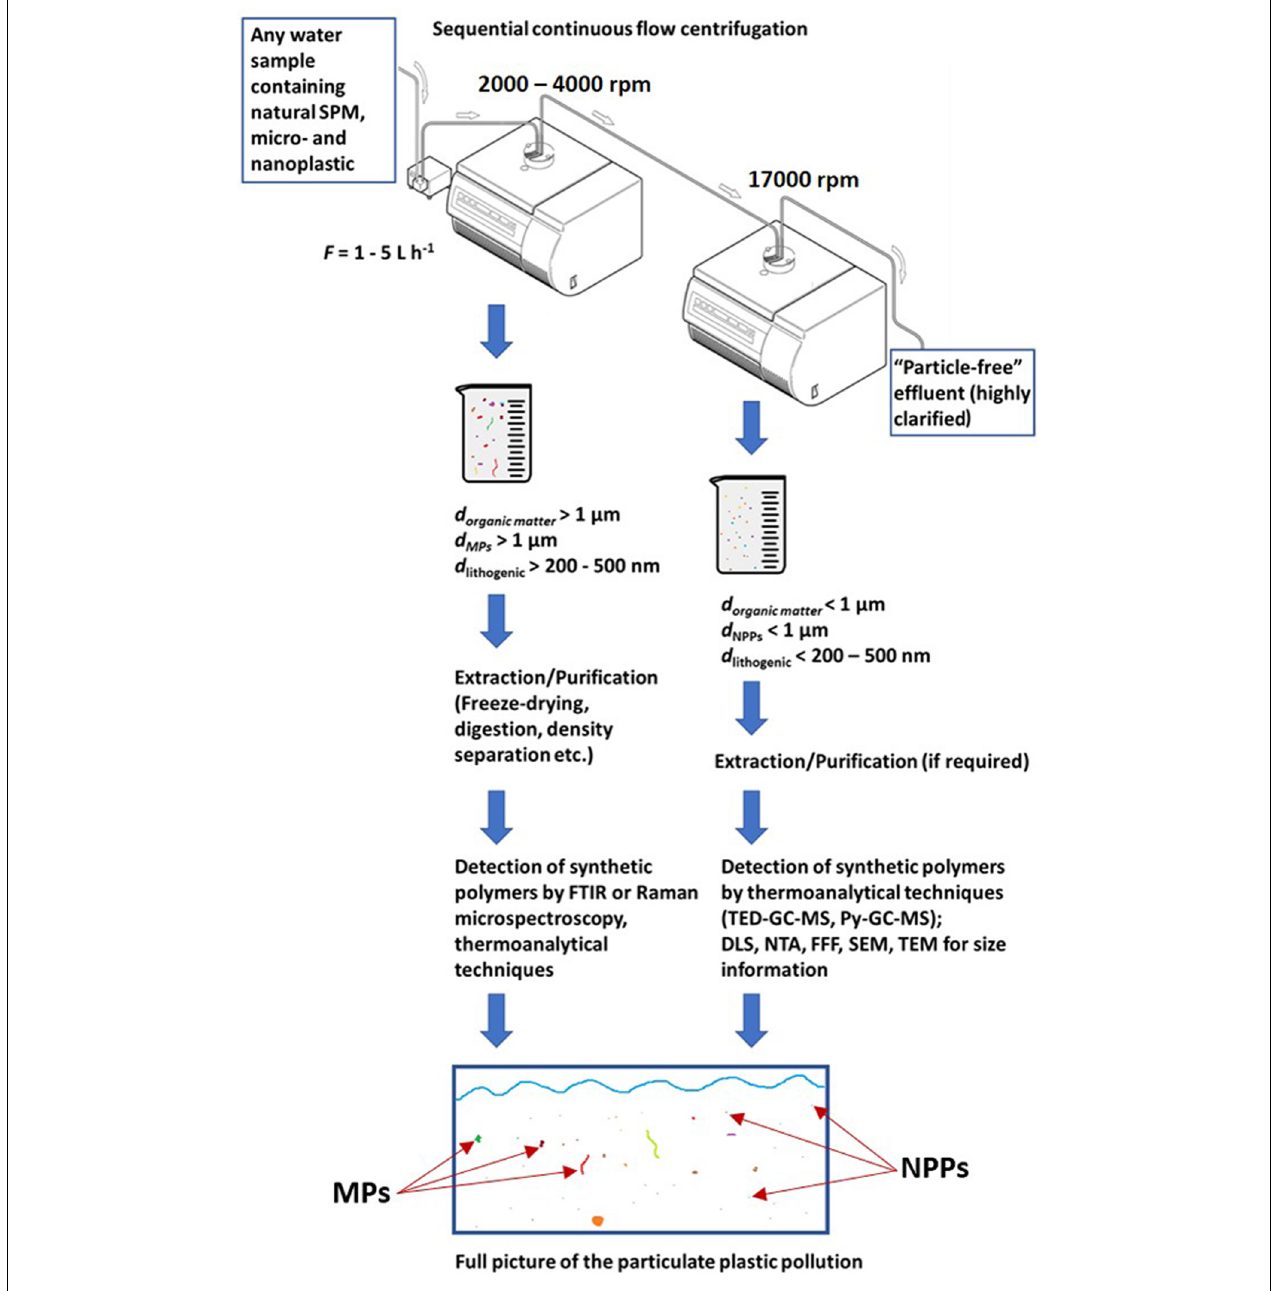
FIGURE 5 | Schematic explanation of the extended utility of the sequential CFC setup as a tool for size- and density selective MP and nanoplastic sampling (modified, © Thermo